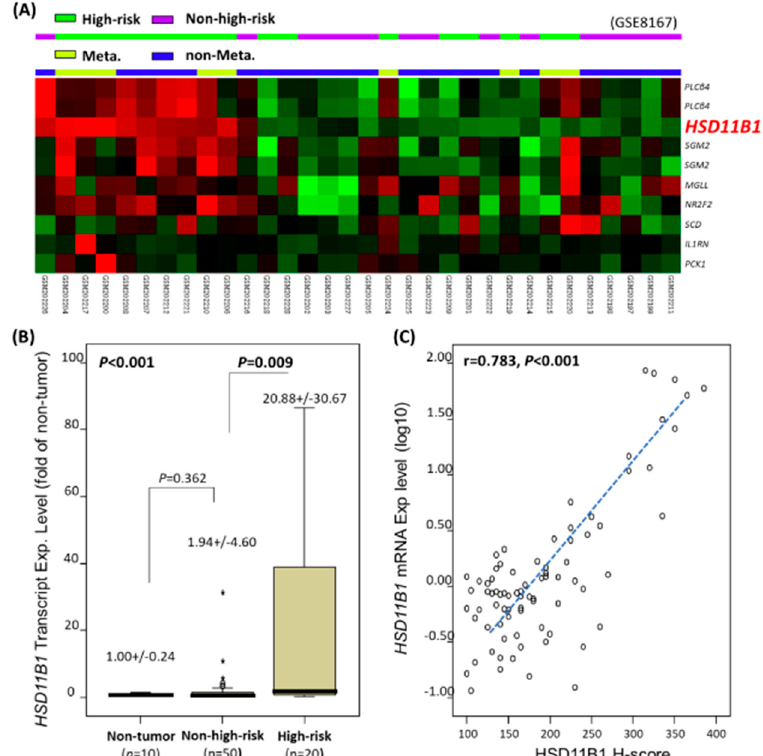
Figure 1. Identification of hydroxysteroid 11-beta dehydrogenase-1 ( HSD11B1 ) as one of the top-rated, differentially upregulated lipid metabolism-regulating genes in aggressive gastrointestinal stromal tumors (GISTs) through data mining. ( A ) The results of unsupervised hierarchical clustering analysis of public GIST transcriptome (GSE8167). Profiles of the differentially expressed candidate genes that were segregated into non-high-risk- and high-risk-predominant groups are labeled in purple and green, and non-metastatic- and metastatic-overrepresented groups are labeled as blue and pale green, respectively, on the top of a heatmap. The official names of differentially upregulated (red) and downregulated (green) genes involved in lipid metabolism (GO: 0006629) among which HSD11B1 was top-rated are presented at right corner; ( B ) Compared to the normal tissues, HSD11B1 mRNA abundance was differentially upregulated across various risk levels in 70 GISTs ( p < 0.001) in QuantiGene assay, chiefly attributable to the apparently higher levels in the high-risk group than that in the non-high-risk group ( p = 0.009); ( C ) In the same set of 70 GISTs used in (B), the scattered plot demonstrated strong correlation between the log 10 -transformed HSD11B1 mRNA level on Y -axis and H-score of HSD11B1 immunoexpression on X -axis. Exp., expression; * outliers.